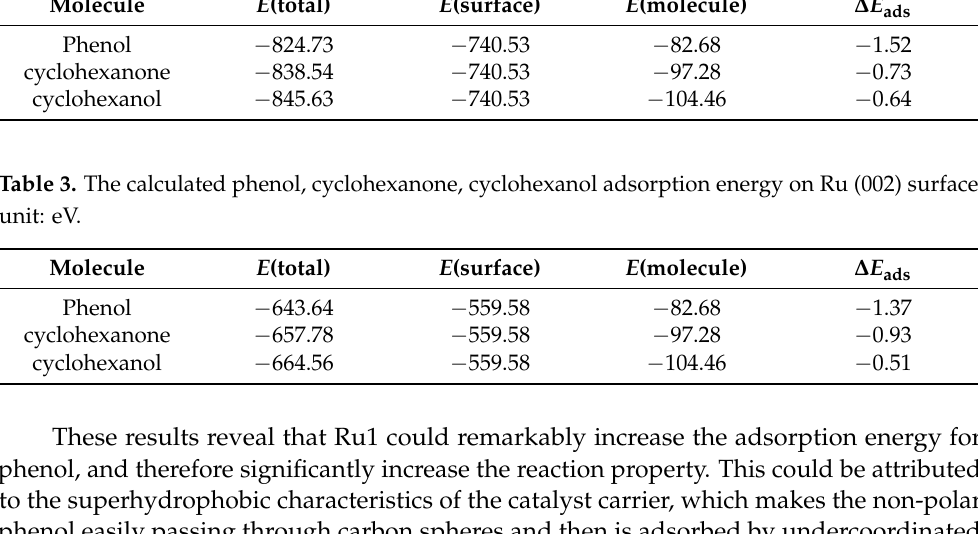
Figure 5. The optimized structures of ( a ) phenol, ( b ) cyclohexanone, ( c ) cyclohexanol adsorbed on